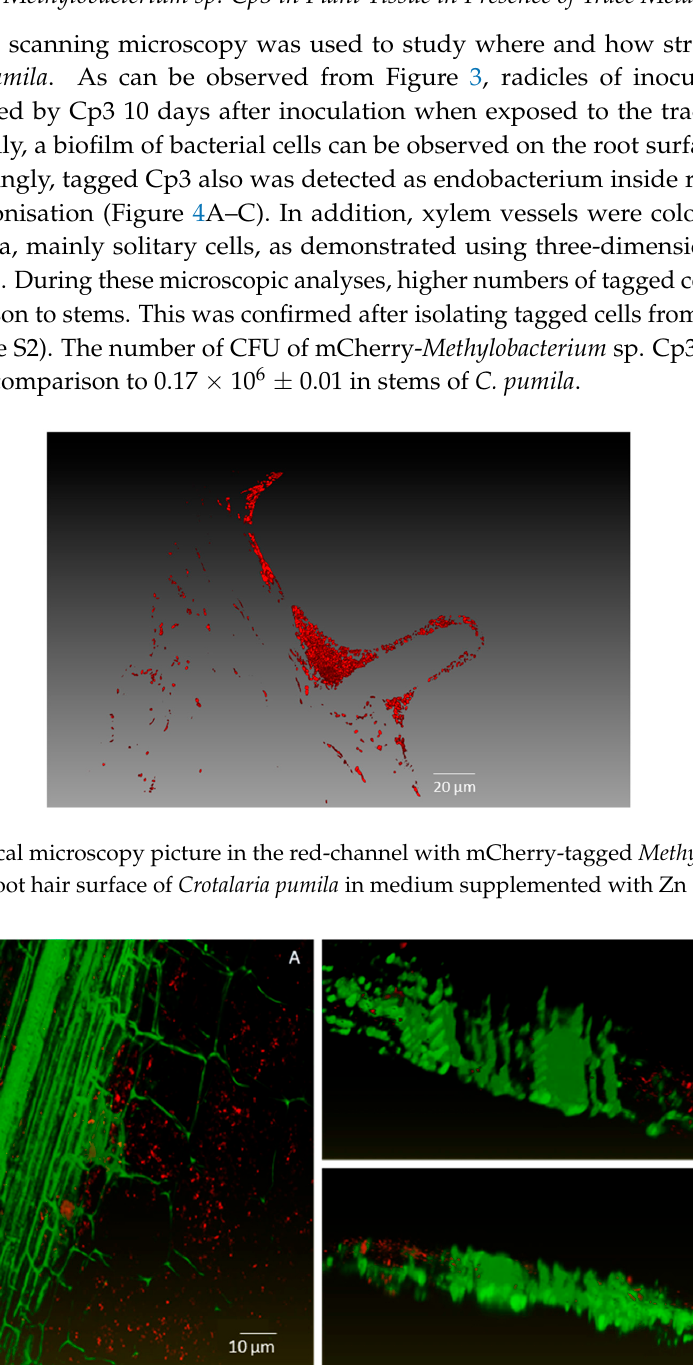
Figure 4. Confocal images of combined m-Cherry fluorescence (red) and plant autofluorescence (green) showing root colonisation by Methylobacterium strain Cp3. Maximum intensity projection ( A ) and volume rendering ( B , C ) where Cp3-mCherry is localized intracellularly in root cortex of Crotalaria pumila . Confocal stack thickness is 58 μ m and was acquired with the Ultra VIEW VoX (PerkinElmer, Zaventem, Belgium) using the CFI Plan Apochromat VC objective 20.0 × 0.75. Z-step was 1 μ m. Three-dimensional models were created with the software Amira 6.0.1 (FEI software, Hillsboro, OR, USA).